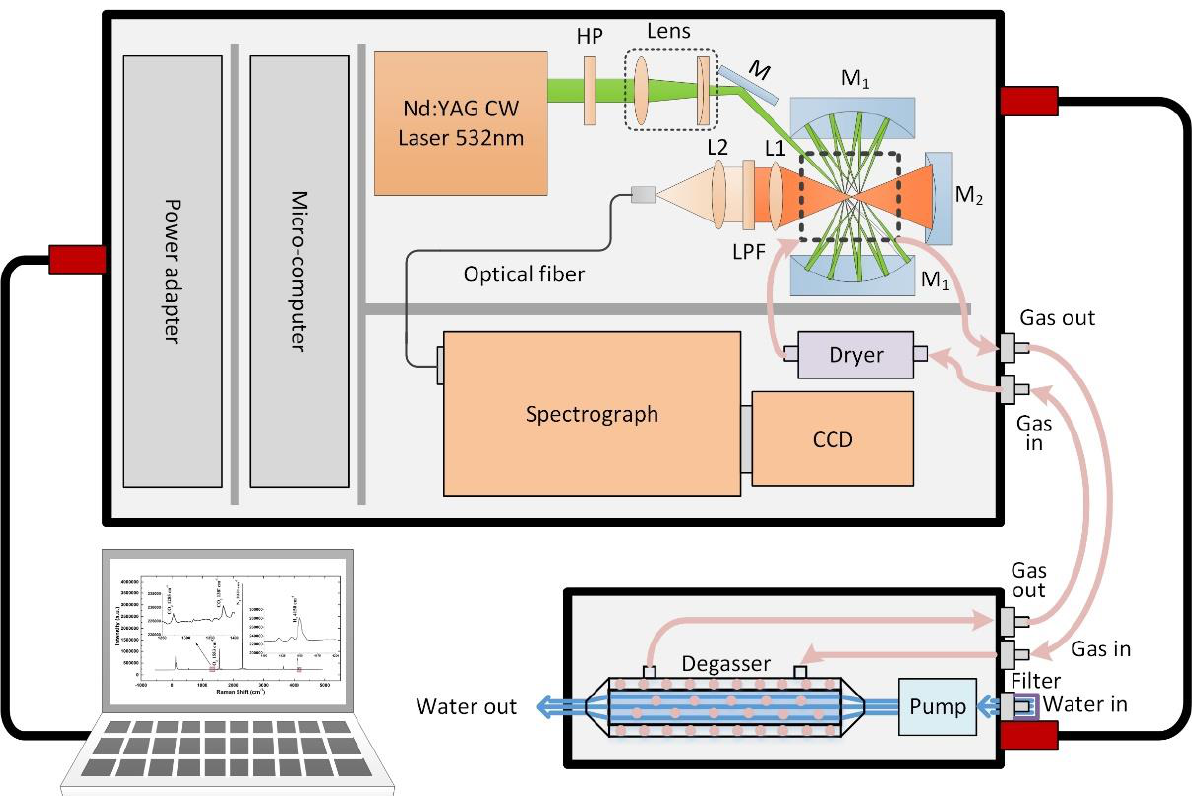
Figure 1. Framework of the in situ underwater Raman system for dissolved gas detection. Inside the degassing vessel, there is a water pump and a degasser. The water is pumped into the pipeline within the degassing vessel through the pump, passing through the filter and flowing into the degasser. The filter, a stainless-steel mesh with a precision of 10 µ m, is used to filter the biological debris, sediments and other large particles in seawater to prevent them from entering into the pump and degasser, and thus, affecting the service life and degassing efficiency of multiple components in the system. The degasser (3M™ Liqui-Cel™, 1.7 × 5.5 MiniModule) is a membrane contactor that uses microporous hollow fiber membranes that are knitted into an array and wrapped around a center tube inside the contactor housing. The hollow fiber membrane is made of polypropylene, with a surface area of 0.54 m 2 and a maximum liquid flow rate of 2.5 L/min. During operation, liquid flows around one side of the membrane and then gas is obtained on the other side of the membrane. Since the microporous membrane is hydrophobic, the membrane will not allow liquid water to pass through the pores into the gas side of the membrane [37]. The large surface area and high liquid flow rate provide a faster degassing rate and make it possible for rapid measurements in seconds. By using four gas-type fittings and two